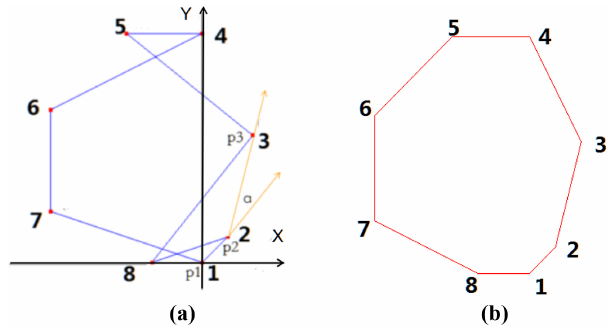
Figure 7. Schematic diagram of sorting of discrete